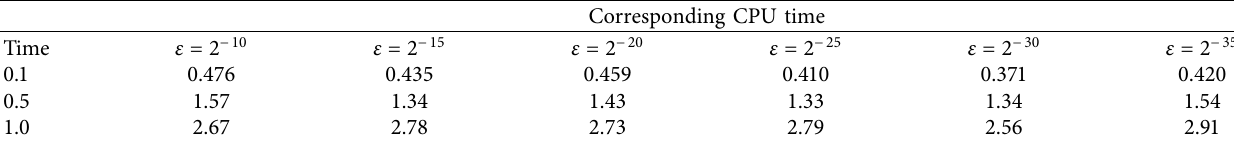
Table 2: CPU time at different time and ε